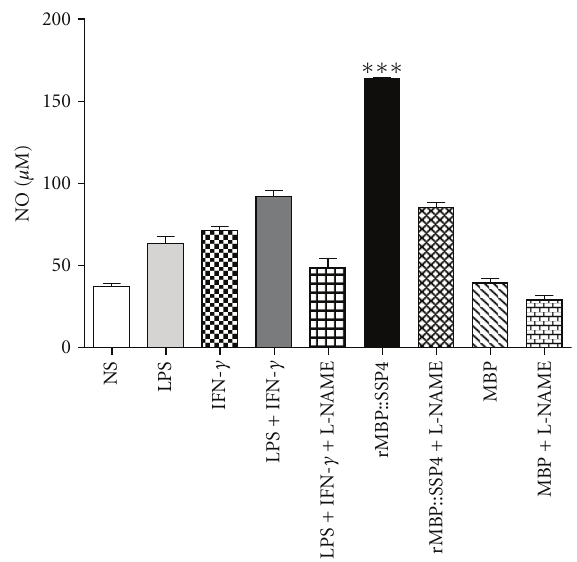
Figure 1: rMBP::SSP4 induces NO synthesis in PBMC. PBMC were stimulated at 48h with di ff erent stimuli. Cells cultured with medium alone were used as controls. Supernatants of cultured cells were harvested, and nitrite concentration was assayed. Data are expressed as means ± SD and are representative of three independent experiments. ∗∗∗ P < 0 . 0001 compared with non- stimulated cells and controls. NS: